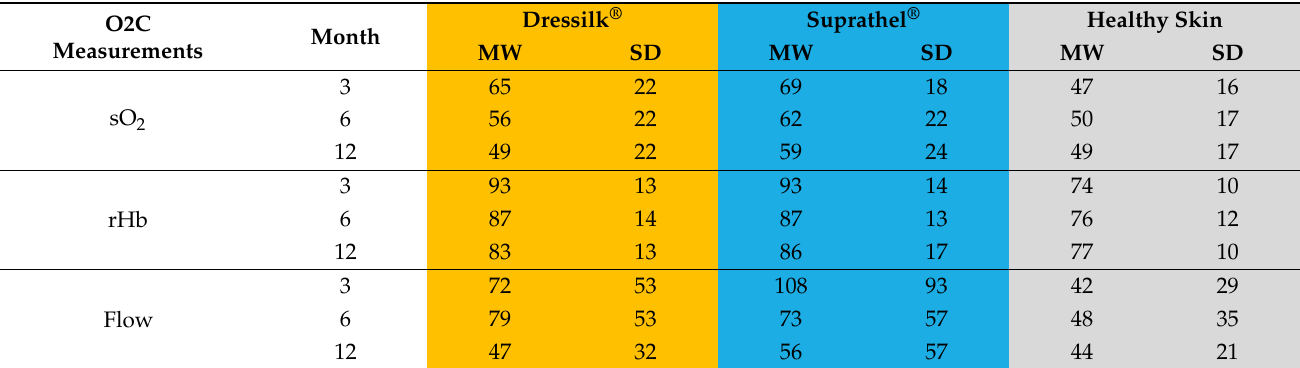
Figure 6. Flow in arbitrary units after 3 months of areas treated initially with Suprathel (blue), Dressilk (orange) and the uninjured control area (green), significant differences marked. Table 5. Oxygen levels in %, rHb/Flow in AU after 3, 6 and 12 months of areas treated initially with Suprathel, Dressilk and the uninjured control